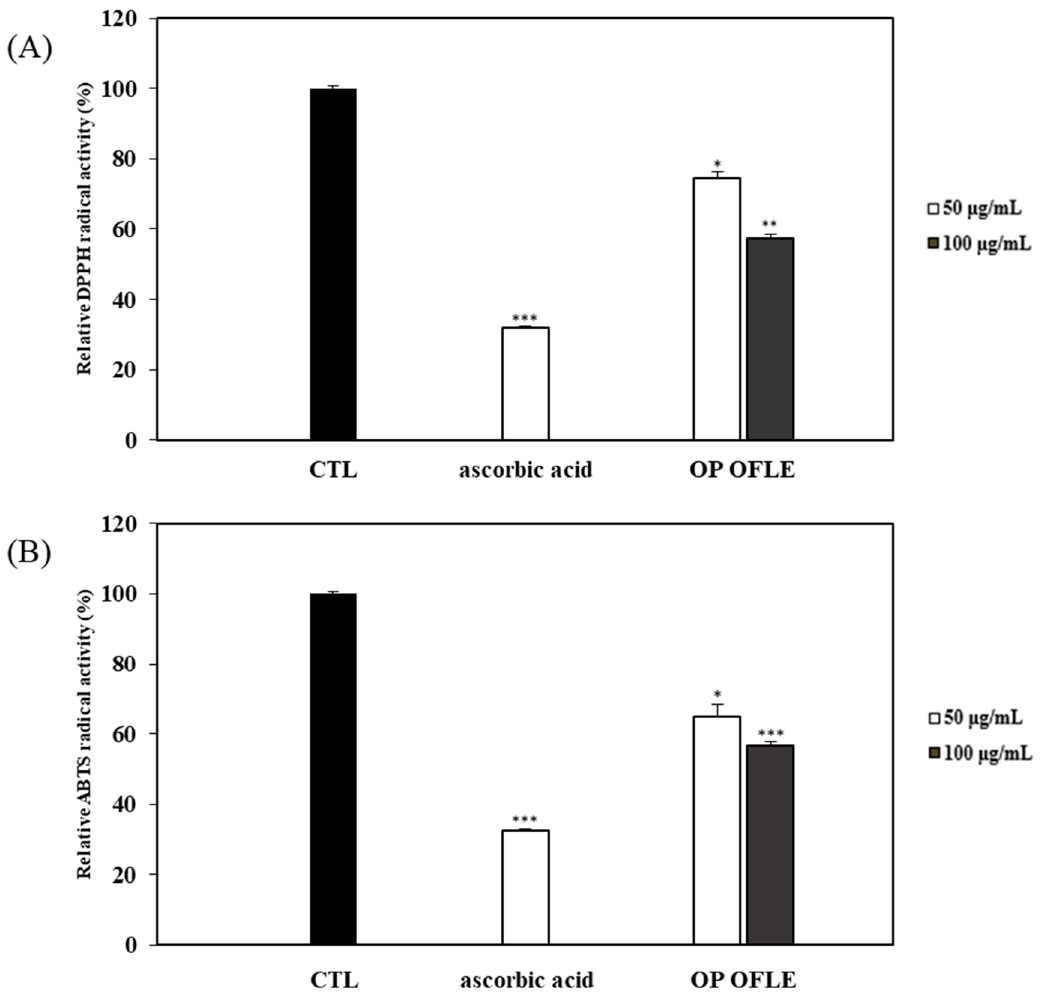
Figure 5. DPPH radical scavenging activity ( A ) and ABTS radical scavenging activity ( B ) of OP OFLE (50 and 100 µ g/mL) are shown. Data are presented as mean ± SD ( n = 3) of three individual experiments. * p < 0.05, ** p < 0.01, *** p < 0.001.